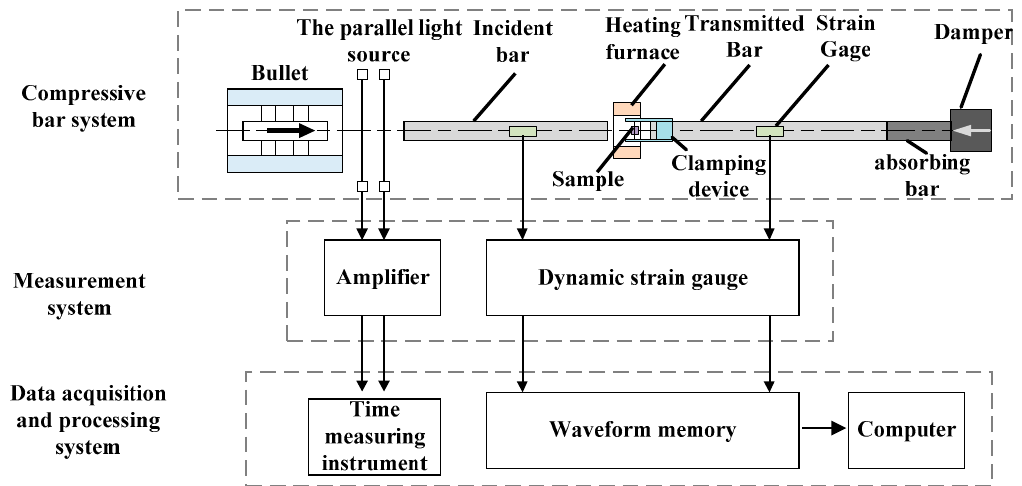
Figure 2. Set-up of high temperature SHPB equipped with a synchronically assembled heating.